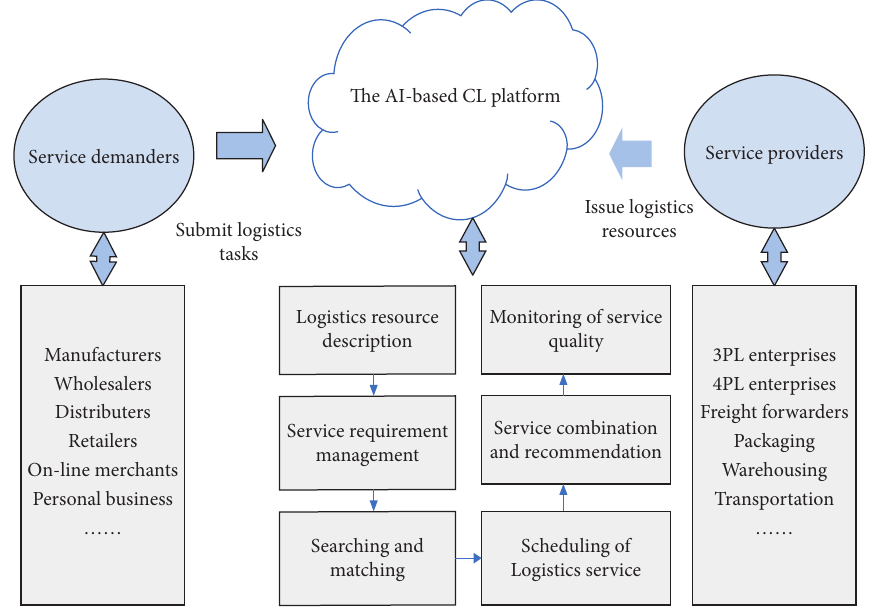
Figure 1: Framework of the AI-based